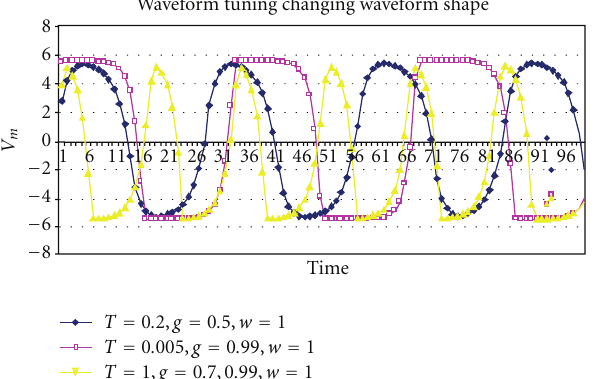
Figure 12: Frequency tuning using the gain parameter. Note that doubling the gain does not exactly double the frequency. This can be seen by counting crests of the pink and green